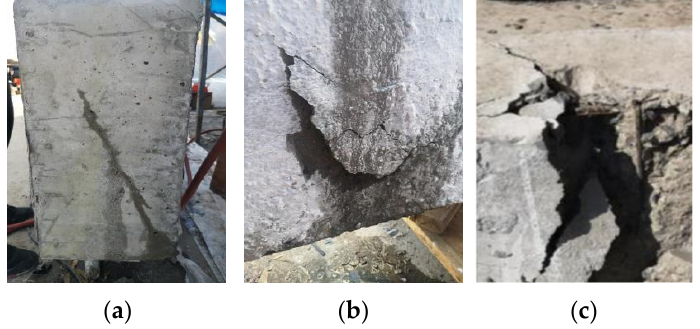
Figure 6. Breaking effect of Hole 1. ( a ) First discharge; ( b ) Fourth discharge; ( c ) Tenth discharge.